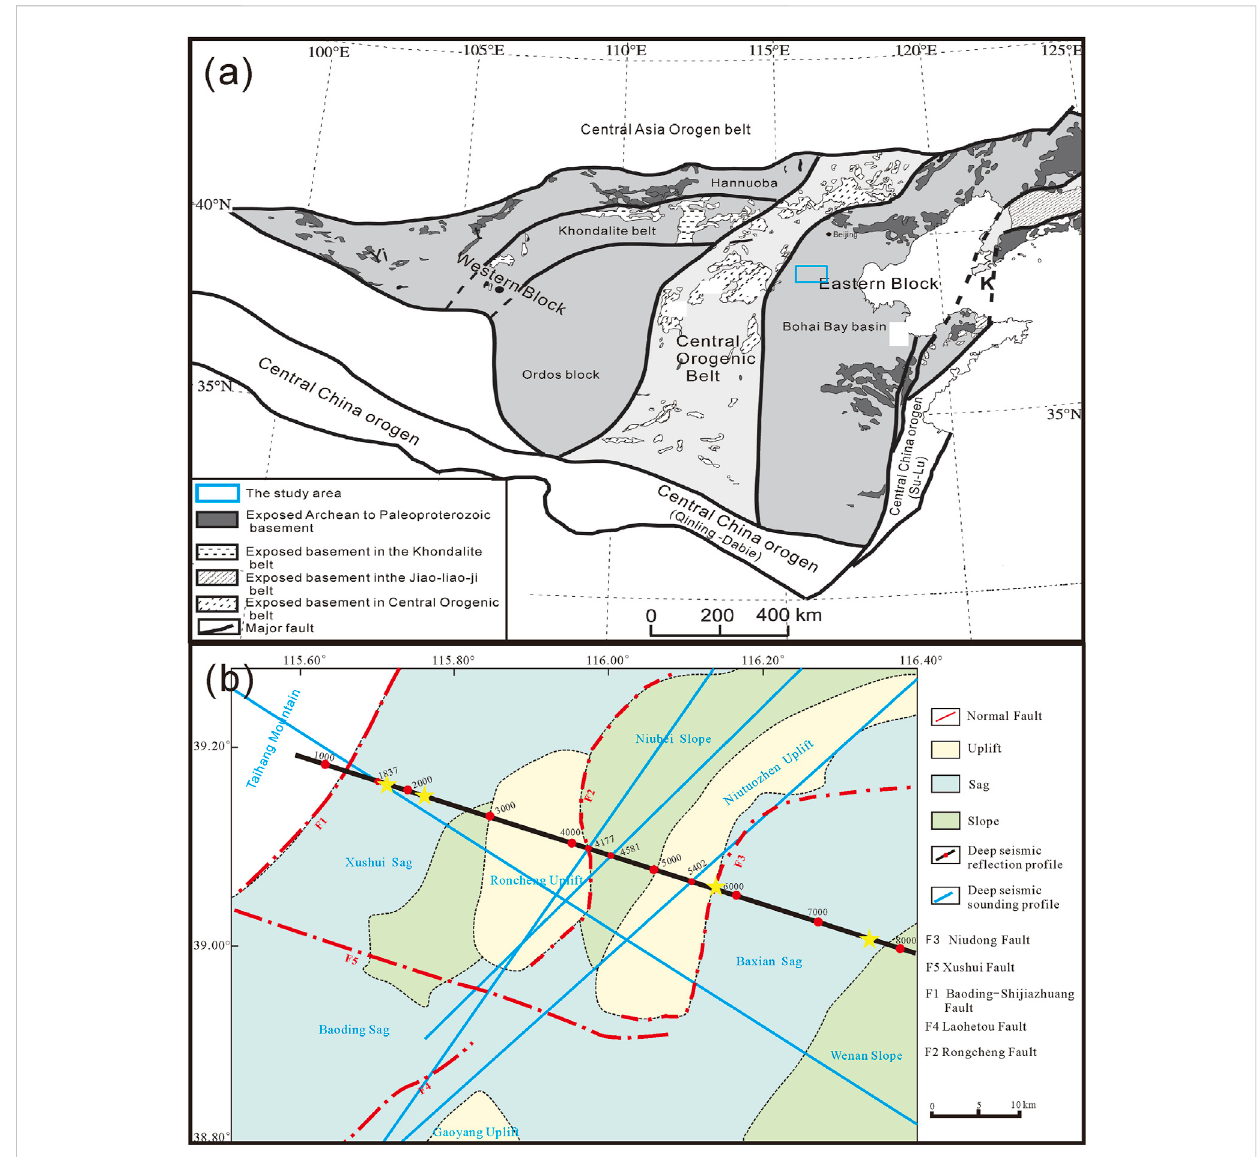
FIGURE 1 Topographic map of the study area showing simpli fi ed tectonic divisions, and location of the seismic surveying line. (A) Division of main tectonic units in the North China Craton and its adjacent areas (Modi fi ed from Zhao et al., 2005) (B) Detailed geologic map of the study area that shows the most relevantgeologicandtectonicfeatures,geologicterranes,andfaults.Thestraightblacksolidlinewithreddotsindicatesthelocationandgeometryofthe seismicpro fi le.Thestraightbluesolidlineindicatesthelocationofseismicsoundingpro fi les.Theyellowstarindicatesthelocationofshotrecordsin Figure